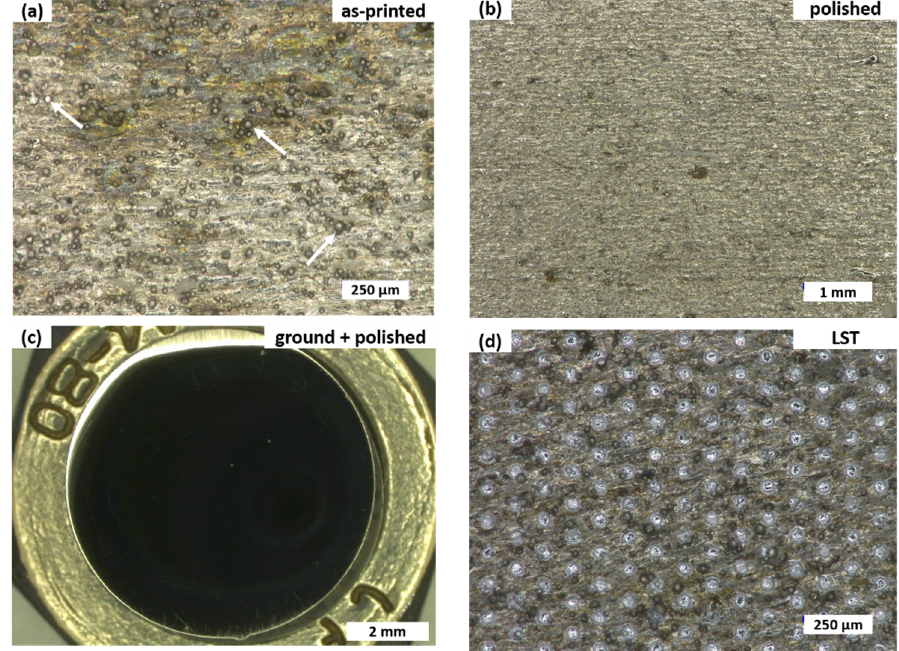
Figure 2. Optical micrographs before tribological tests. ( a ) As-printed, ( b ) polished, ( c ) ground and polished, and ( d ) laser-surface-textured. H13 steel samples initially were prepared by selective laser melting (SLM). Magnification for each image chosen such to best represent samples. Unmelted powder in ( a ) is highlighted by white arrows.